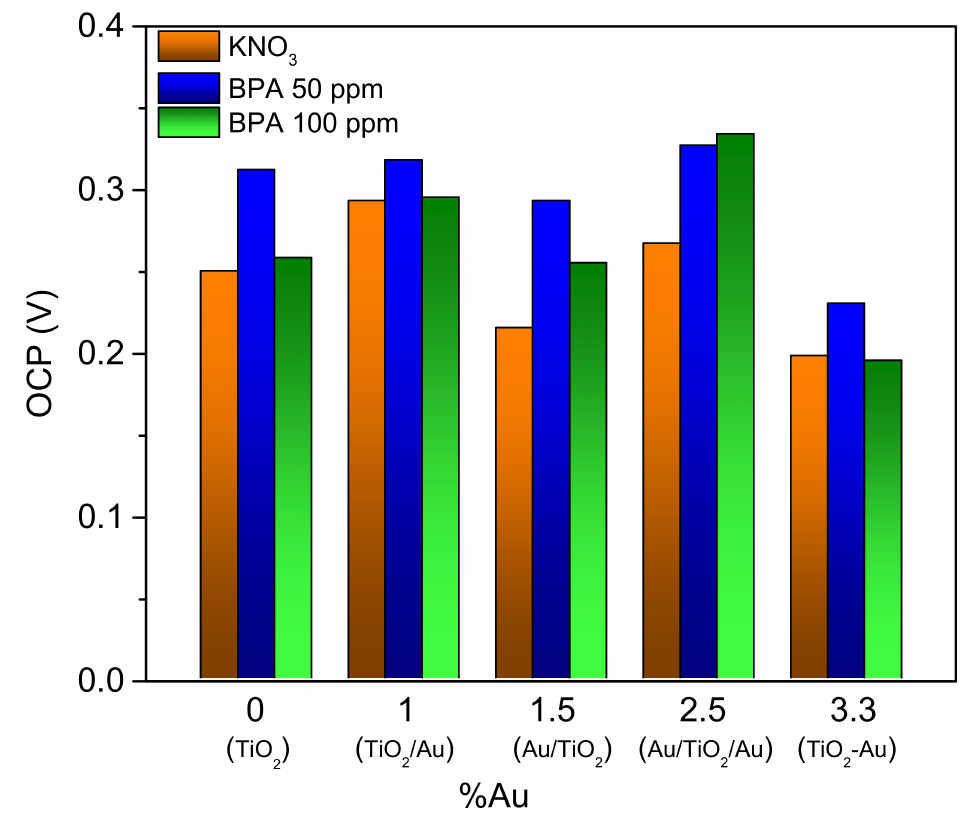
Figure 3. OCP values measured in supporting electrolyte and in two different BPA concentrations at the different samples.